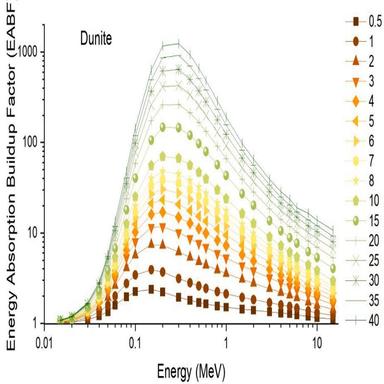
Variation of energy absorption buildup factor (EABF) values of dunite as a function of photon energy (MeV).